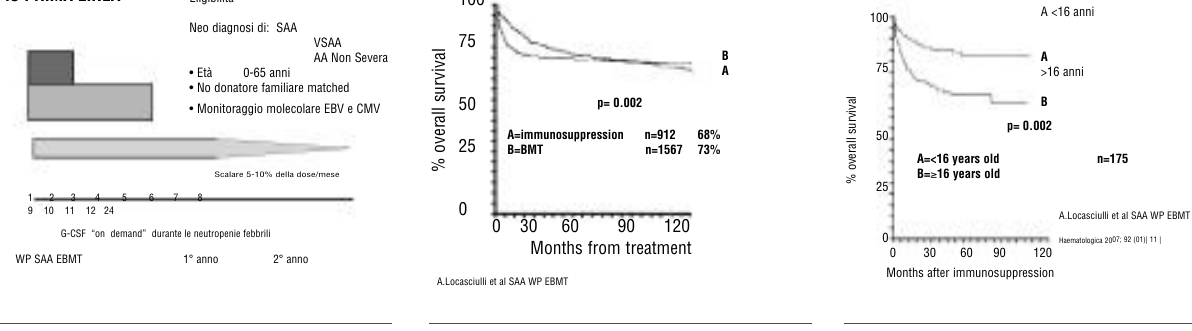
Figura 2. Sopravvivenza a 10 anni dopo terapia IS vs TCSE in 2079 pazienti AAA.